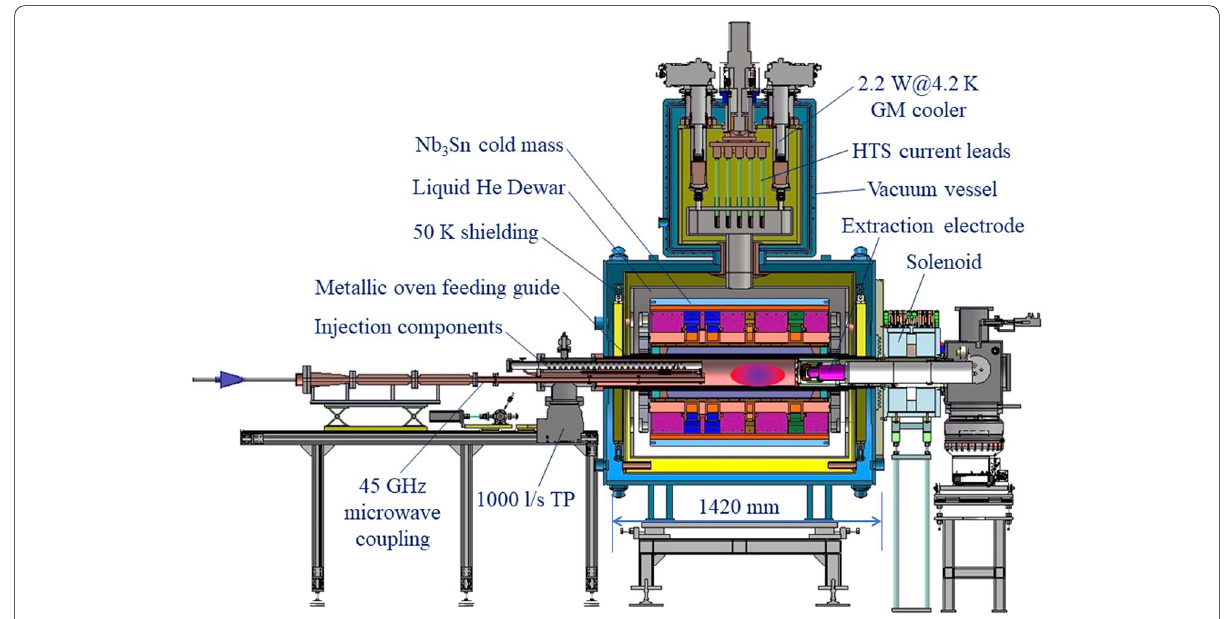
Fig. 4 Structure of FECR with major components